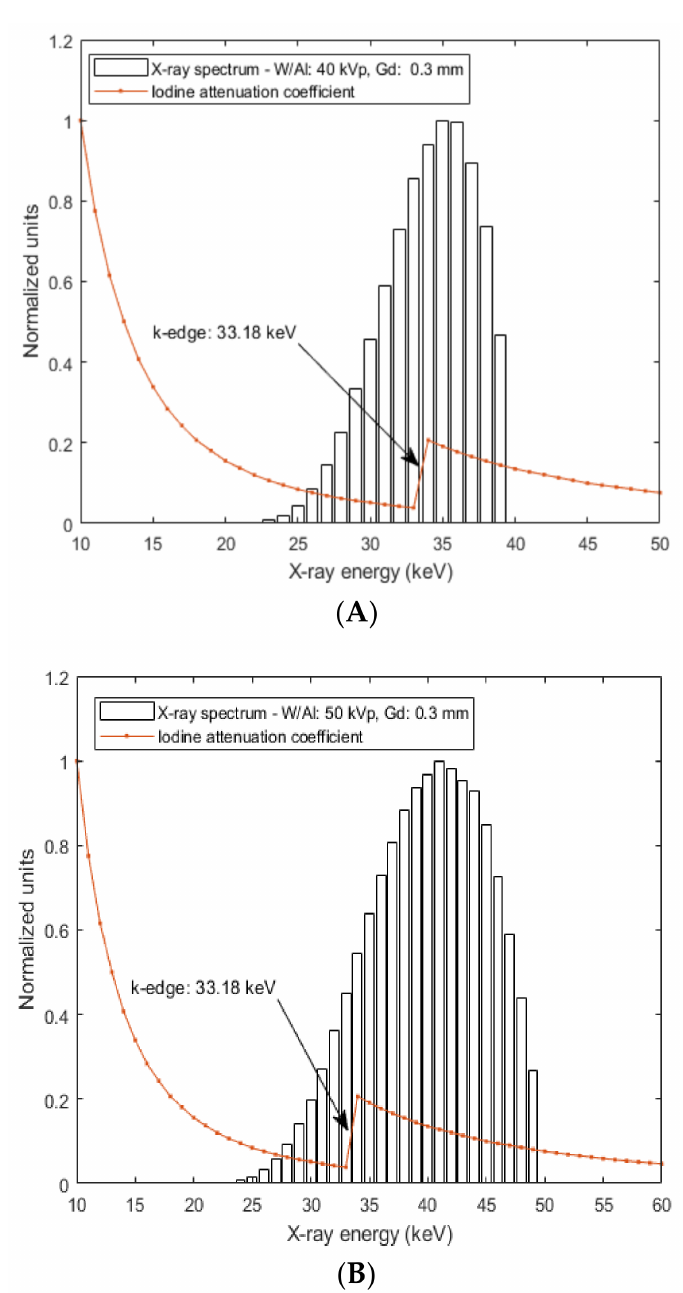
Figure 2. Figure illustrates two X-ray spectra: ( A ) 40 kV- W/Al (1.6 mm) and ( B ) 50 kV- W/Al (1.6 mm) with additional filtration 0.3 mm Gd. The simulation of the X-ray spectrum was carried out by an X-ray simulation tool [17]. In addition, the variation of the attenuation coefficient as a function of the X-ray energy (k-edge 33.18 keV) is also provided for the Iodine (I) element. The calculation was carried out using XmuDat database